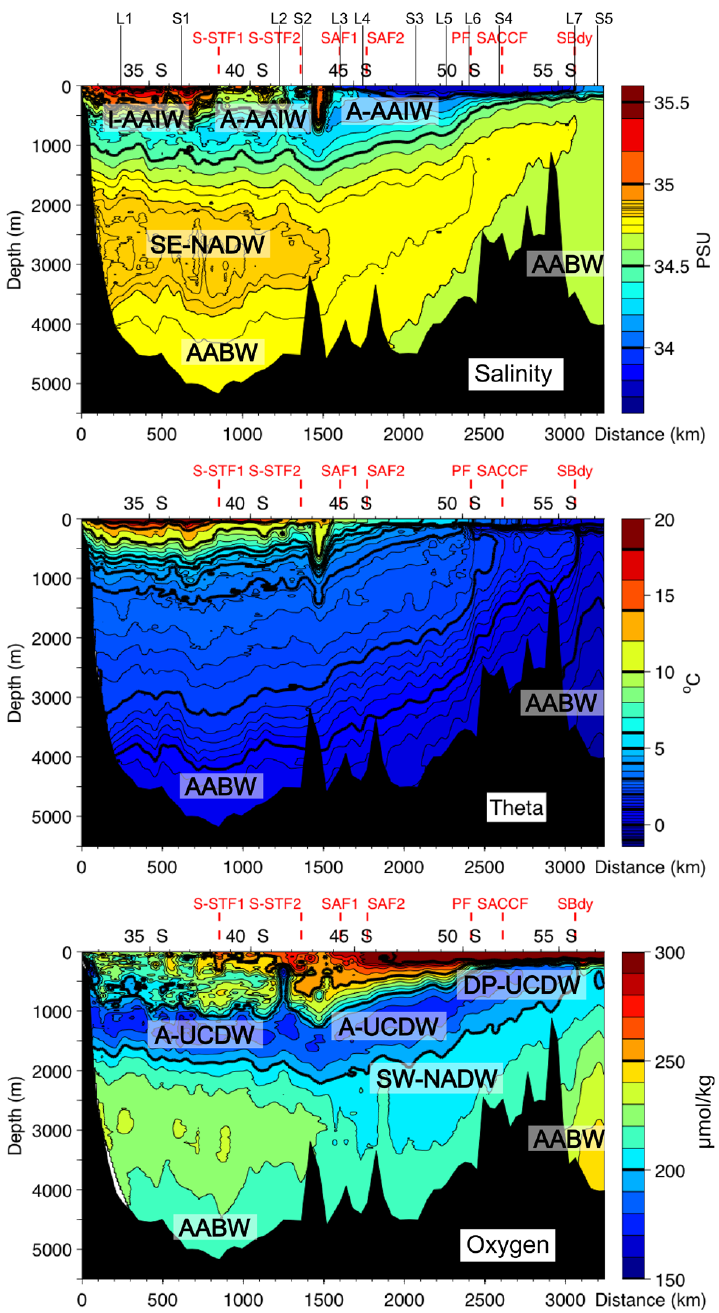
Fig. 2. Contour plots of salinity, potential temperature and oxygen versus depth along the MD166 BONUS-GoodHope transect from north (left) to the south (right) of the section (S. Speich et al., personal communication, 2011). The name, origin and characteristics of the water- masses are given in Table